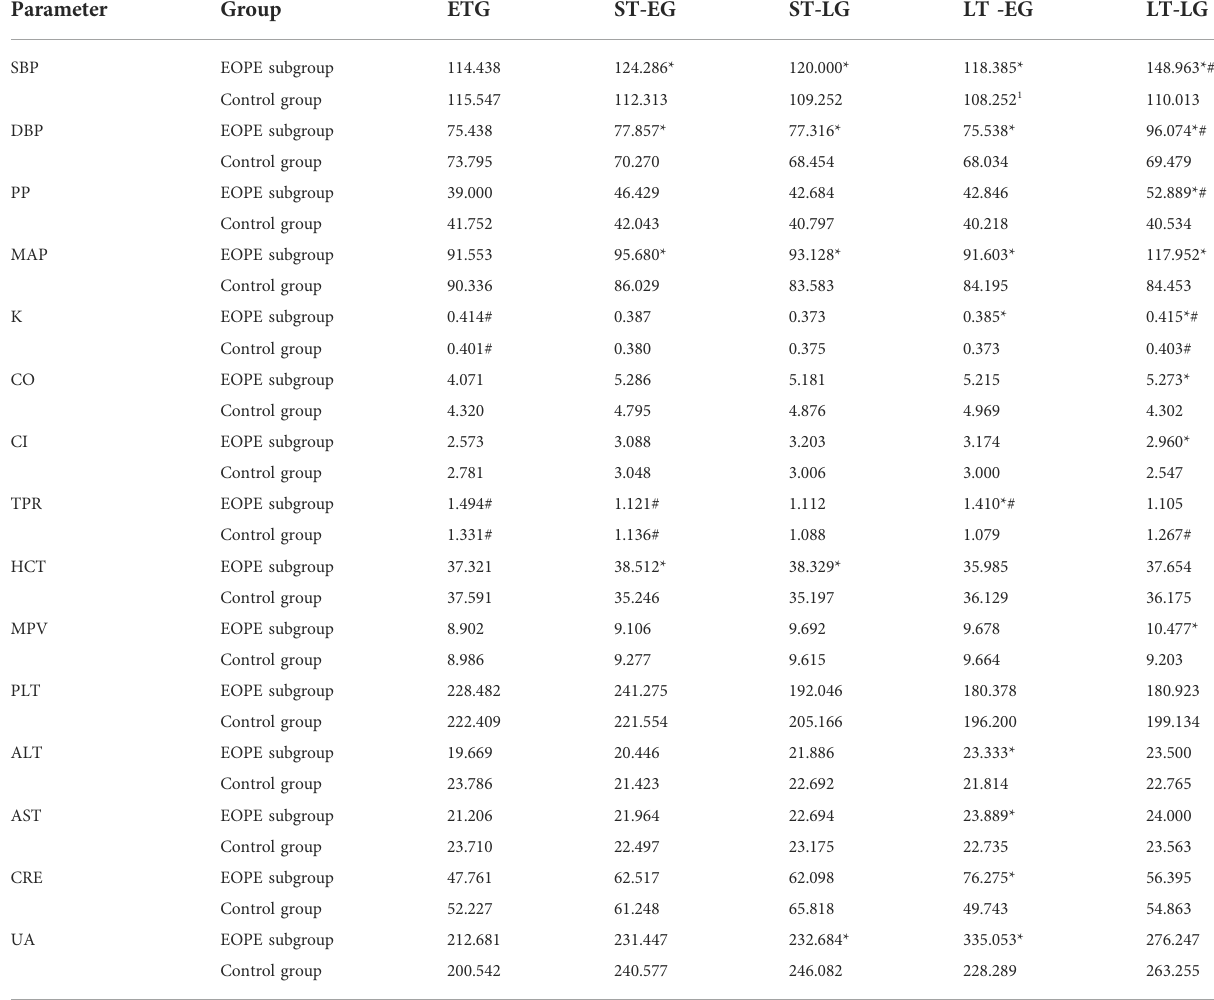
TABLE 4 Sensitivity analysis of H and B parameters in EOPE subgroup and control group.